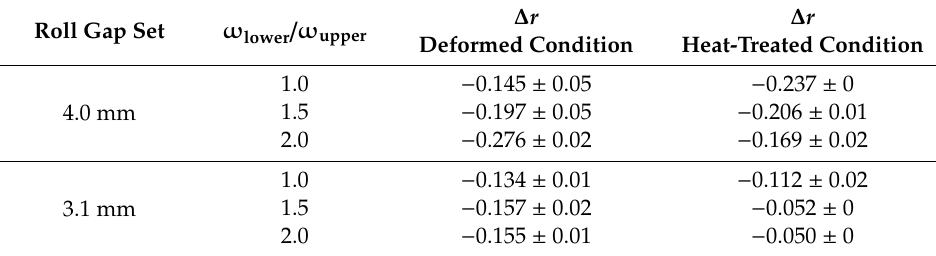
Table 3. Planar anisotropy indicator ∆ r for deformed and heat-treated